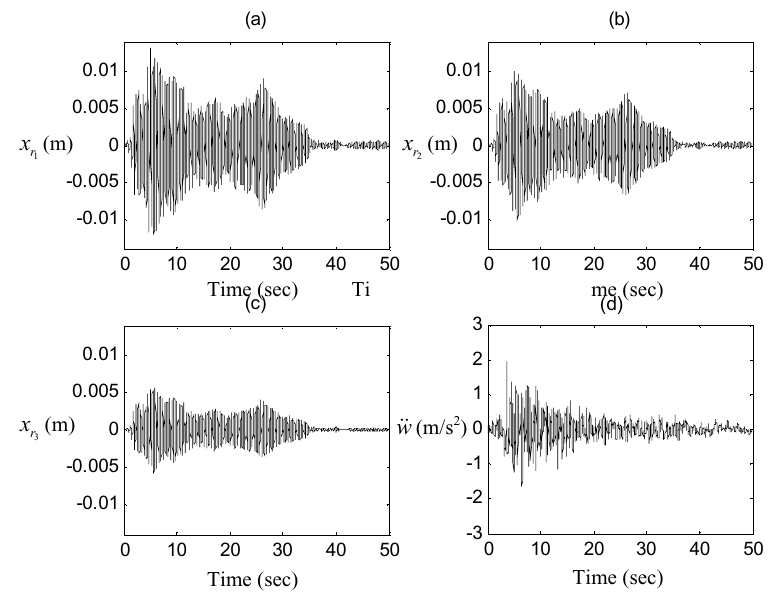
Fig. 2. Relative displacements of the uncontrolled system. (a) First mass x r 1 = x 1 ; (b) Second mass x r 2 = x 2 − x 1 ; (c) Third mass x r 3 = x 3 − x 2 ; (d) Base acceleration.